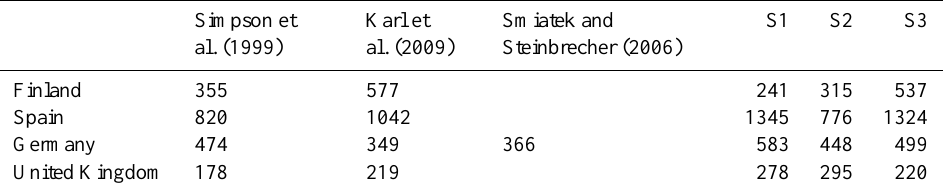
Table 8. Comparison of total annual BVOC emissions (Gg yr − 1 ) in different countries to literature data. Base years of Simpson et al. (1999), Karl et al. (2009) and Smiatek and Steinbrecher (2006) are 1999, 2005 and 1994–2003, respectively. Note that the vegetation inventories of Simpson et al. (1999) and S2 as well as Karl et al. (2009), Smiatek and Steinbrecher (2006) and S3 are